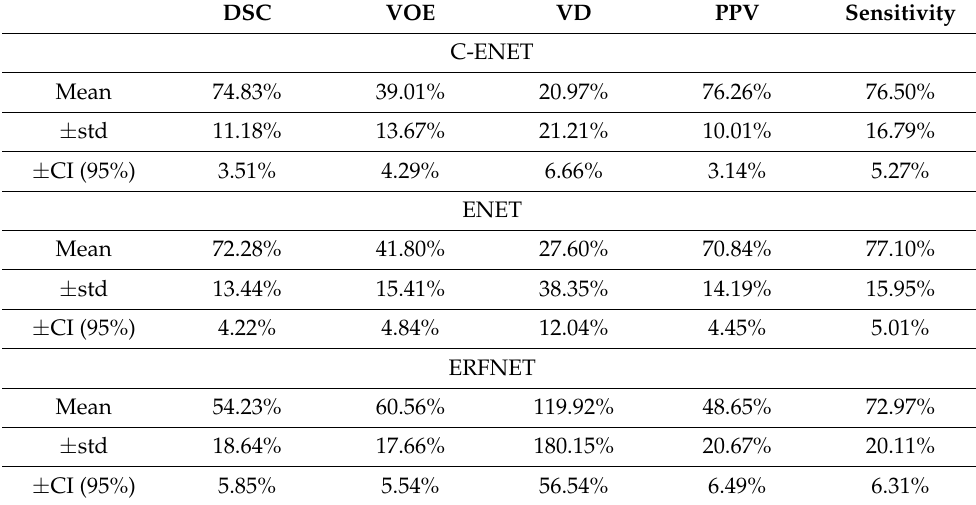
Table 2. Performance of DL